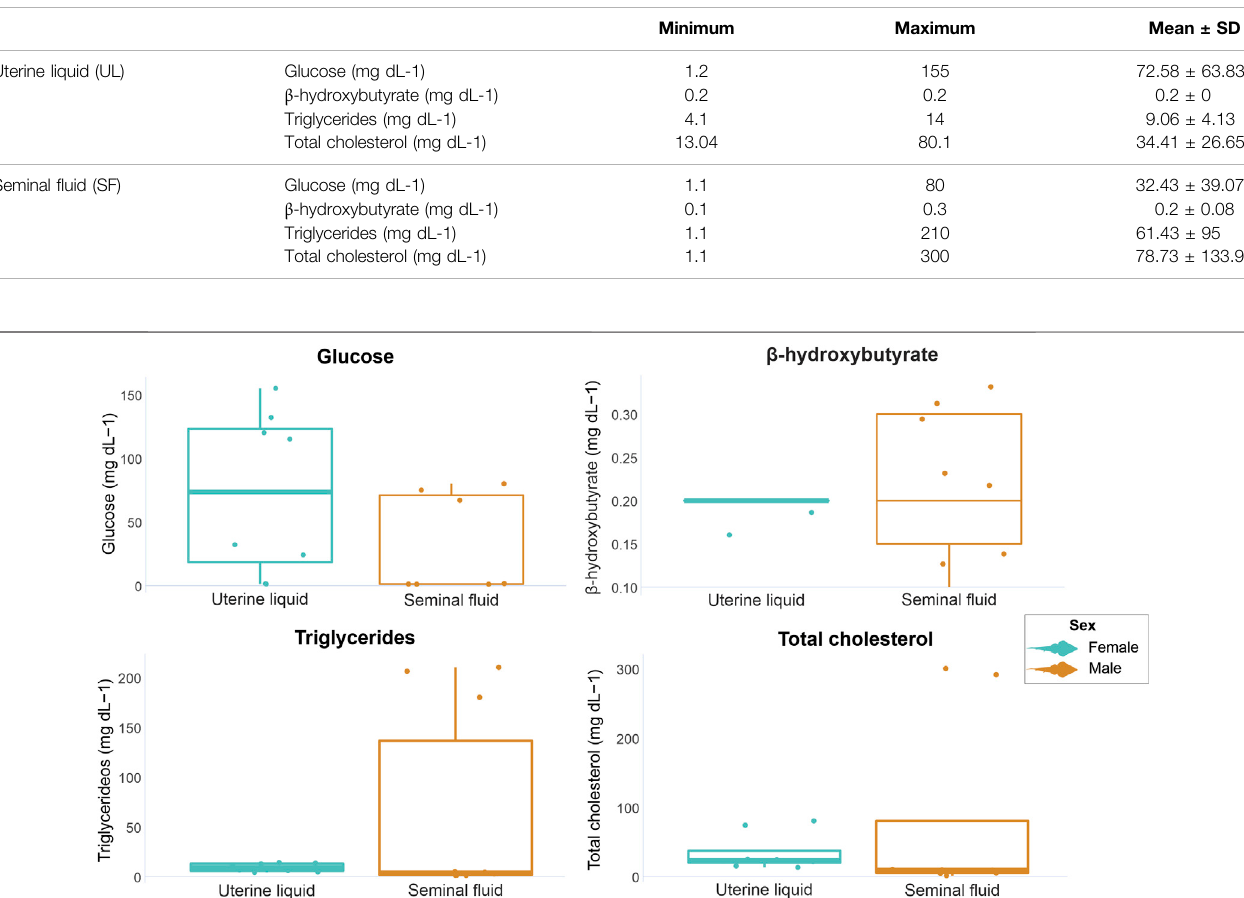
Frontiers in Physiology |